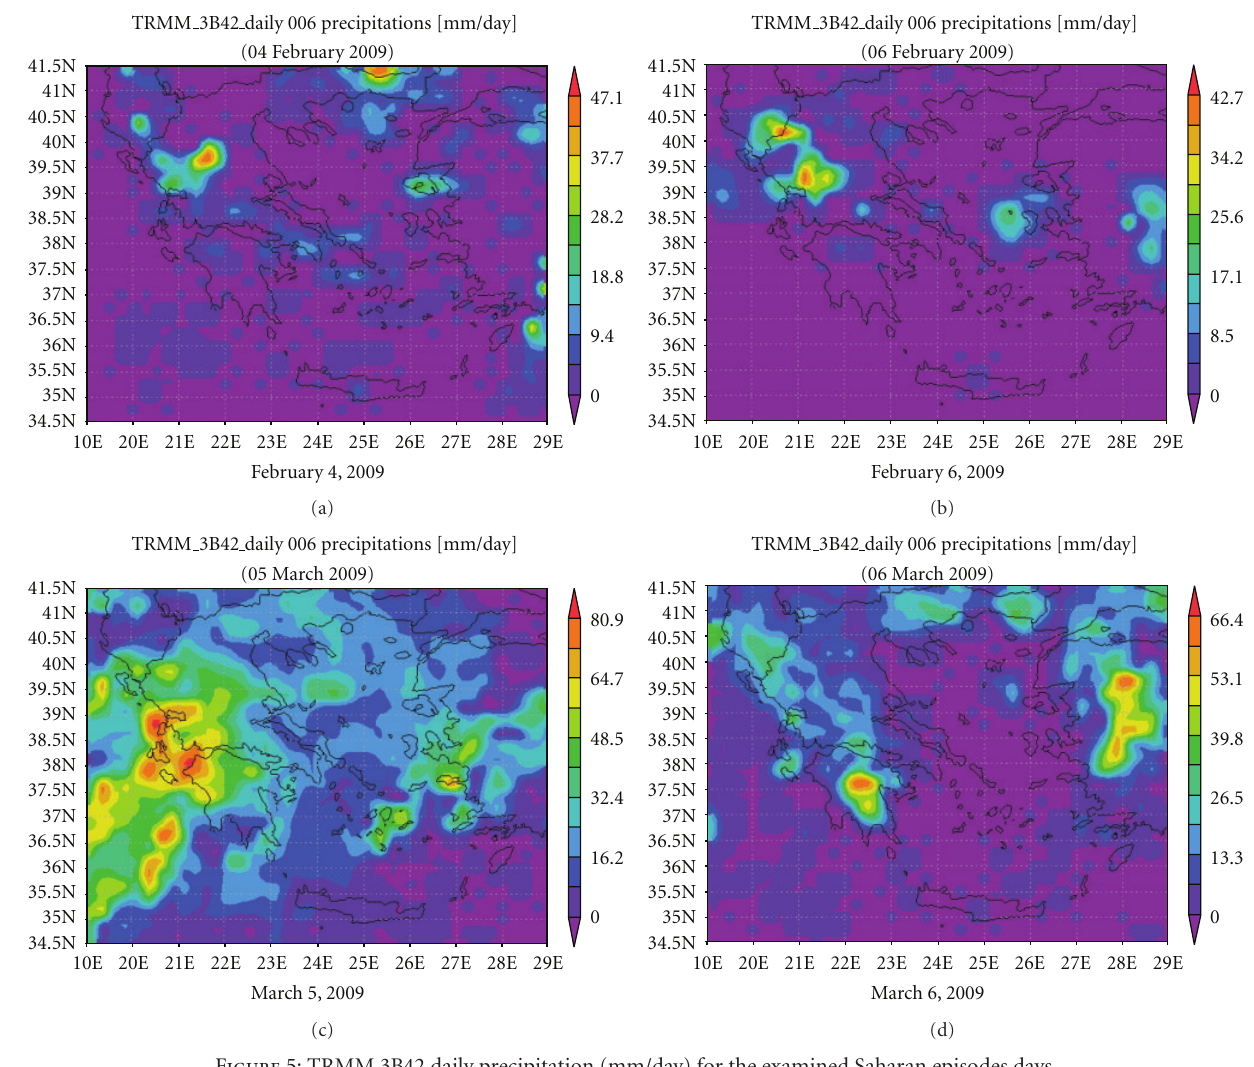
Figure 5: TRMM 3B42 daily precipitation (mm/day) for the examined Saharan episodes